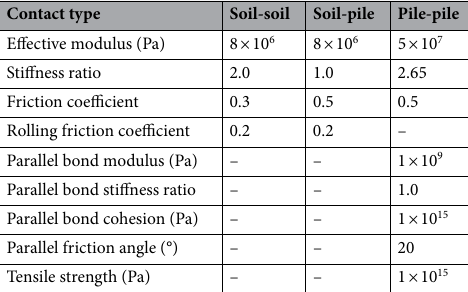
Table 1. Parameters used in the numerical